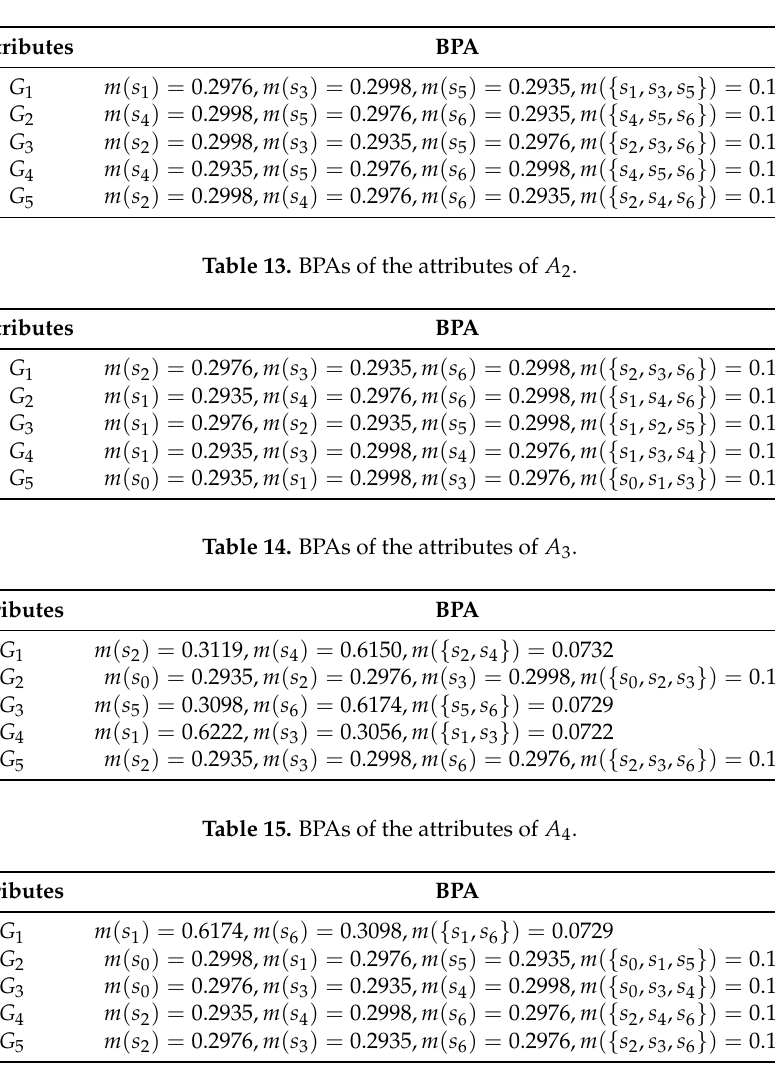
Table 12. BPAs of the attributes of A 1 .